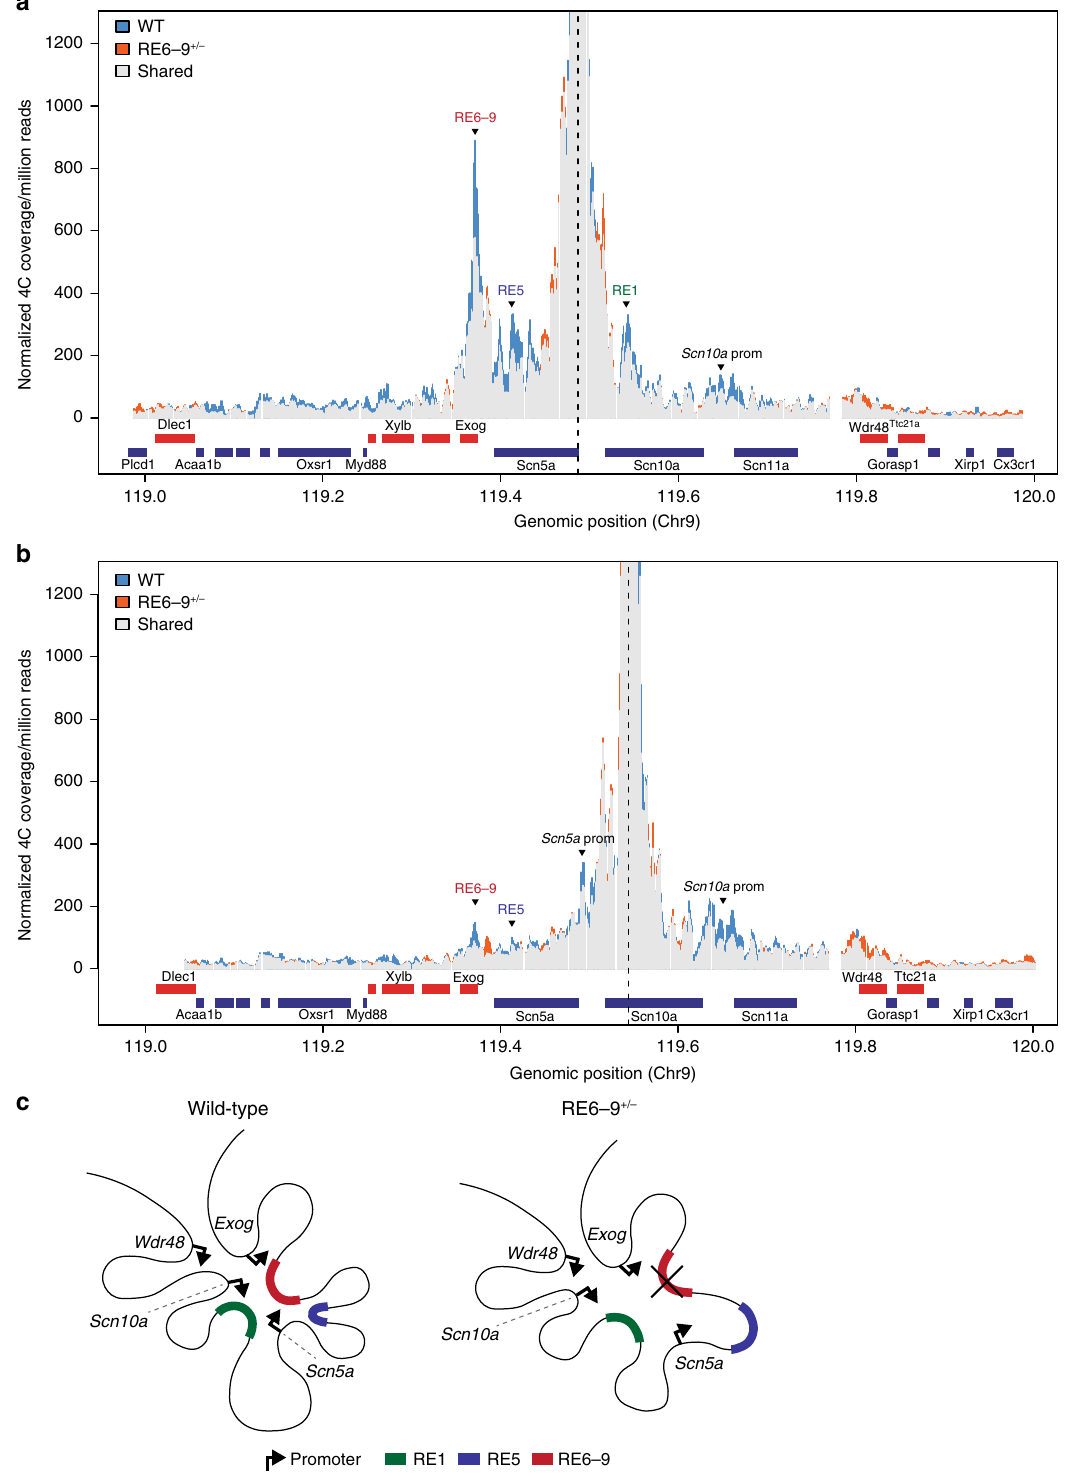
Fig. 3 The three-dimensional organization of the Scn5a-Scn10a locus changes upon deletion of RE6-9. a , b 4C contact pro fi les of wildtype, n = 3 (WT, blue), RE6-9 + / − , n = 3 (orange) and shared signal (gray) with viewpoints set on the Scn5a promoter ( a ) and the intronic regulatory element RE1 located in Scn10a ( b ). The intradomain interactions between Scn5a , Scn10a , RE6-9, RE1, and RE5 are reduced in heterozygous RE6-9 mice. c Model of interaction of the Scn5a- Scn10a locus. Regulatory elements RE1 (green), RE5 (blue) and RE6-9 (red) with the Scn5a , Scn10a , Exog , and Wdr48 promoters (black